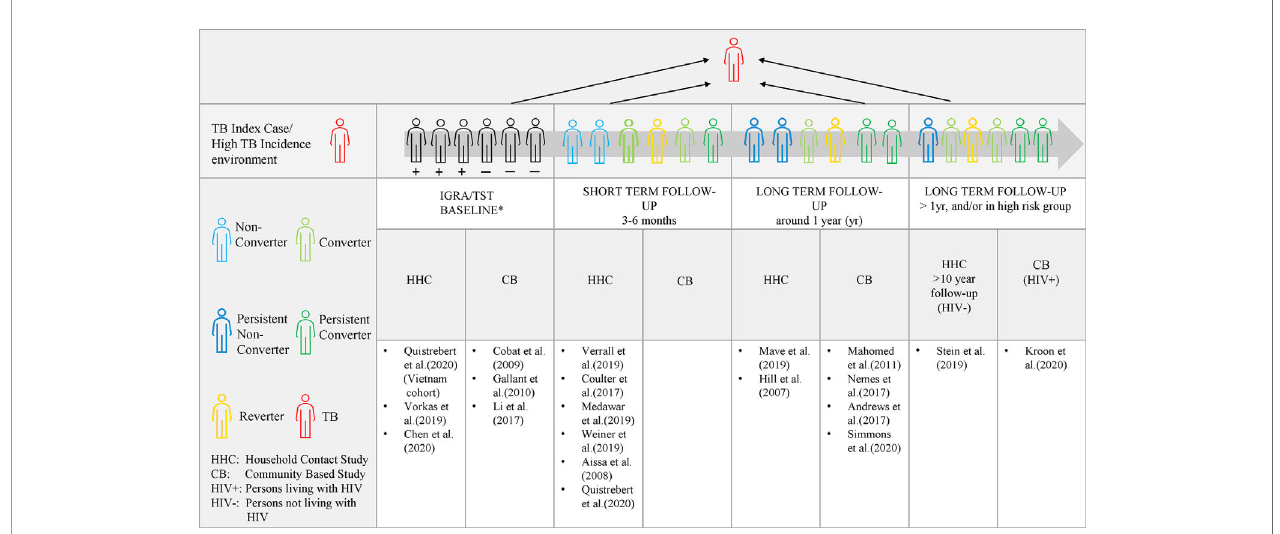
FIGURE 1 | The spectrum of IGRA/TST nonconverters. Evidence of protection to Mtb at a shorter time period in relation to the index case, allows the study of correlates of protection which may be overcome by exposure intensity and frequency (represented by the grey arrow). Long term follow-up allows for a more robust and extreme phenotype de fi nition as in Stein et al. (followed for 10 years) and Kroon et al. (in persons living with HIV). Persistent non-conversion is not absolute and may eventually be overcome by time and very high levels of exposure or continuous exposure. *At baseline, individuals may test either TST/IGRA positive, negative or be